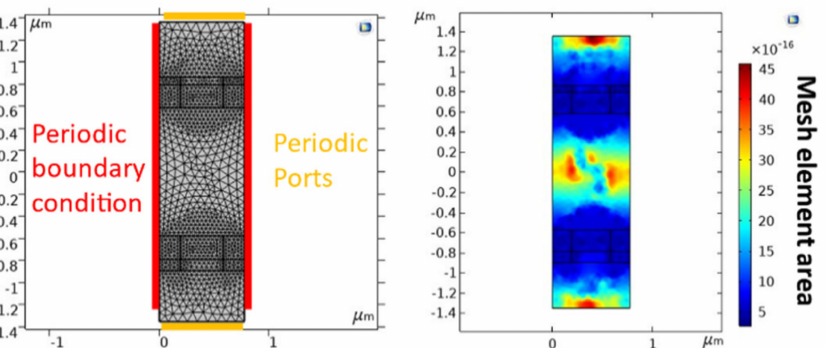
Figure 11. ( Left panel ) Setup of the frequency domain simulation showing that the structure is segmented in triangle areas with a maximum size of 38nm, and that it is excited by a periodic port either from the top or bottom, while keeping the periodic boundary condition on the left and right. ( Right panel ) Distribution map of the area of each mesh element; the scale bar unit is m 2